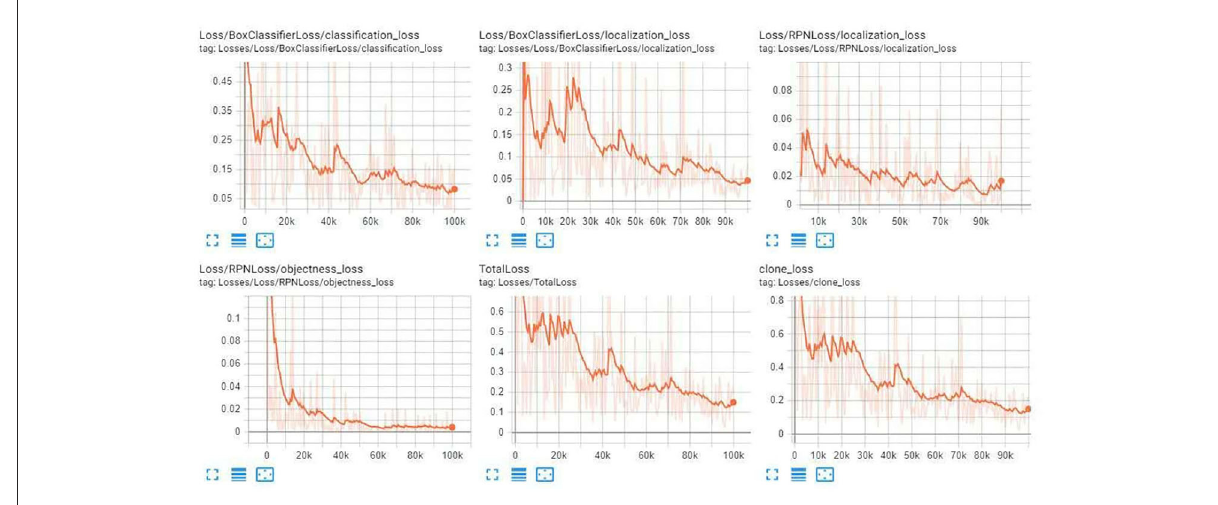
FIGURE8 iNaturalist Species-trained models training loss graph.